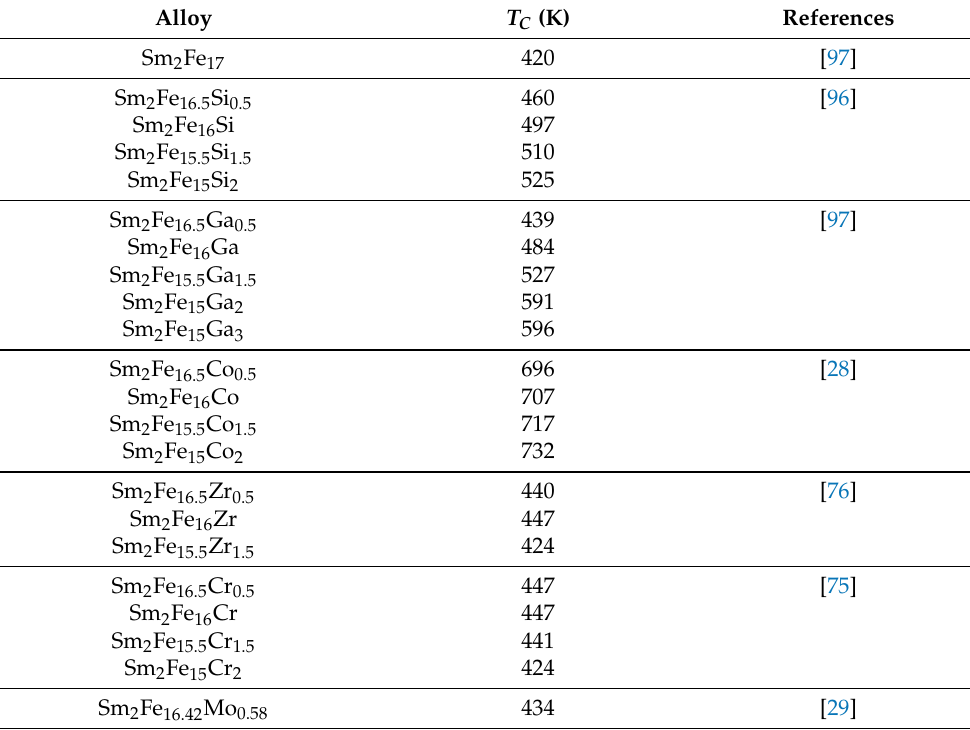
Table 6. Curie temperature of Sm 2 Fe 17 − x M x ( M = Si, Ga, Co, Zr, Cr, Mo) and ( x = 0, 0.5, 1, 1.5, 2)